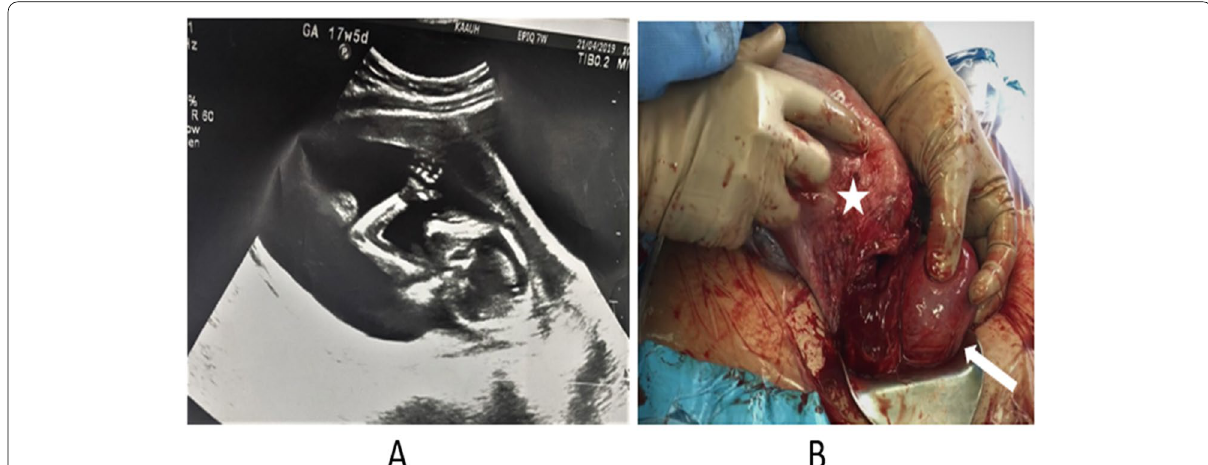
Fig. 4 The first pregnancy at 2019 showed A ultrasound during pregnancy and B lower segment CS in the right hemi-uterus which was obstructed before (star) and left hemi-uterus